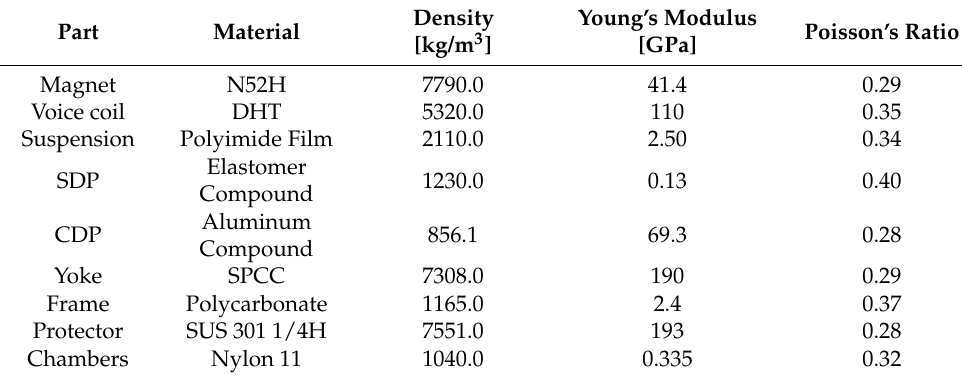
Figure 6. Electromagnetic analysis results. Table 1. Mechanical material properties.